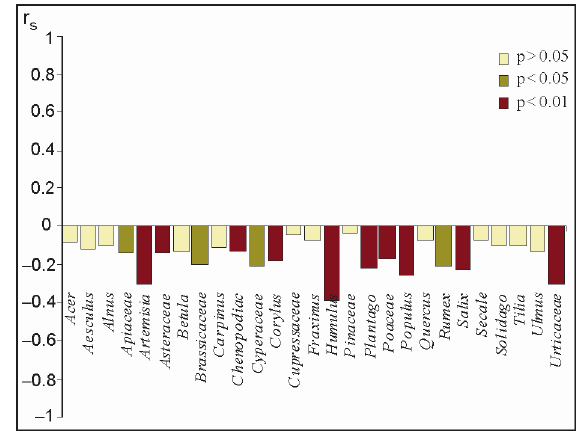
Fig. 4. Correlation coefficients (r s ) of plants pollen concentra- tion of various genera and families during the pollen season and amount of precipitation in 2004 – 2009